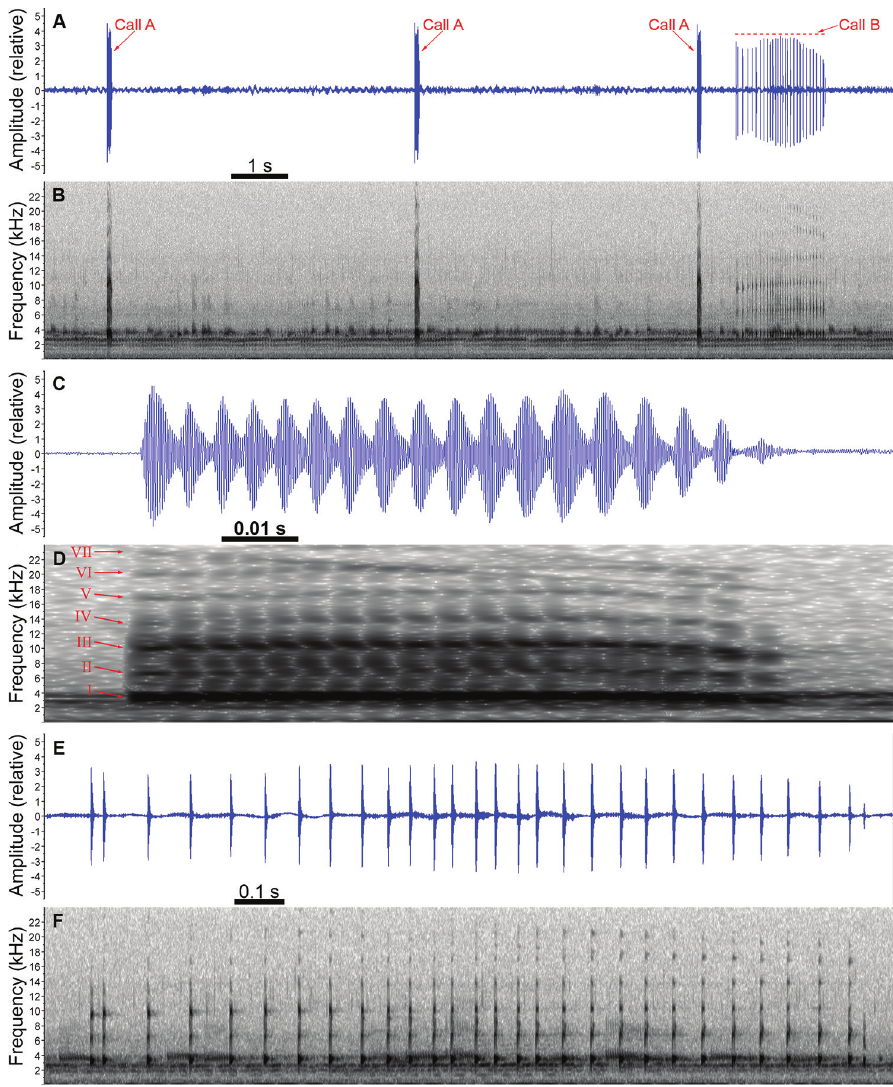
Figure 1. Calls of Boana latistriata from its type locality. A Waveform and B spectrogram showing three instances of call A and one of call B emitted in sequence C waveform and D spectrogram of a call A, in detail, indicating seven visible harmonics numbered I to VII E waveform and F spectrogram of a call B, in detail. Images were obtained using Raven Pro 1.5 software. Spectrograms parameters: window type = Hann, size = 256 samples, overlap = 99%. Individual ZUFRJ 15076 (snout-vent length = 39.3 mm), recorded at a temperature between 12 and 14 °C. nant frequency from 3187.5 to 3750.0 Hz (mean = 3473.6 Hz, SD = 178.6, Mo = 3468.8 Hz, n = 38 pulses), and last pulse dominant frequency from 2625.0 to 3656.2 Hz (mean = 3399.7 Hz, SD = 195.8, Mo = 3375.0 Hz, n = 38 pulses). Table 2 shows the parameters for each recorded